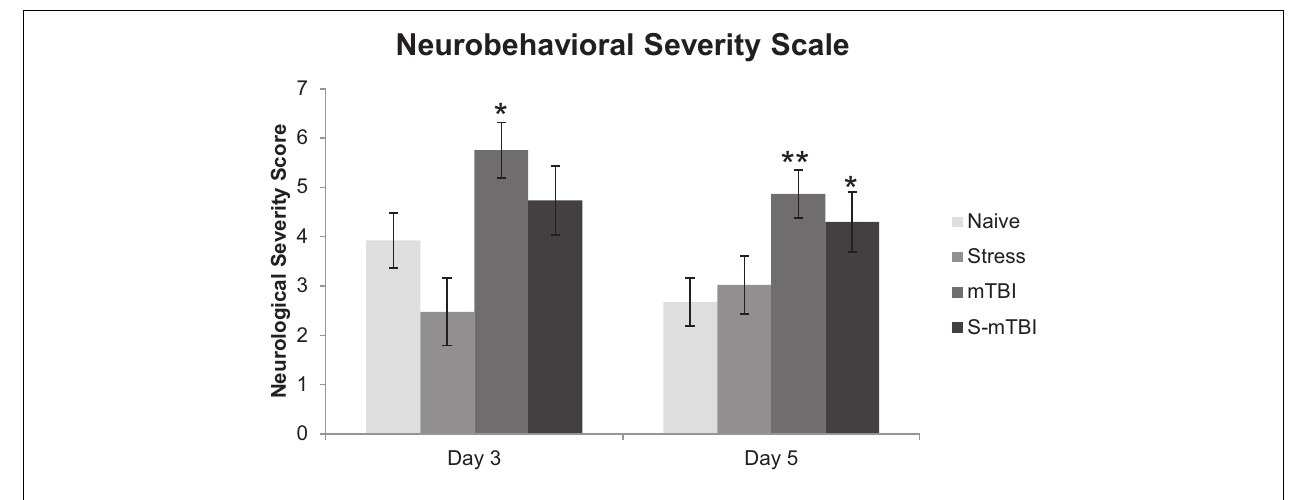
at baseline (BL), and 3 and 5days post injury. Neurobehavioral assessment post injury was covaried for baseline measurements due to differences at baseline between groups. * p < 0.05, ** p < 0.01 vs. Naïves, respectively.